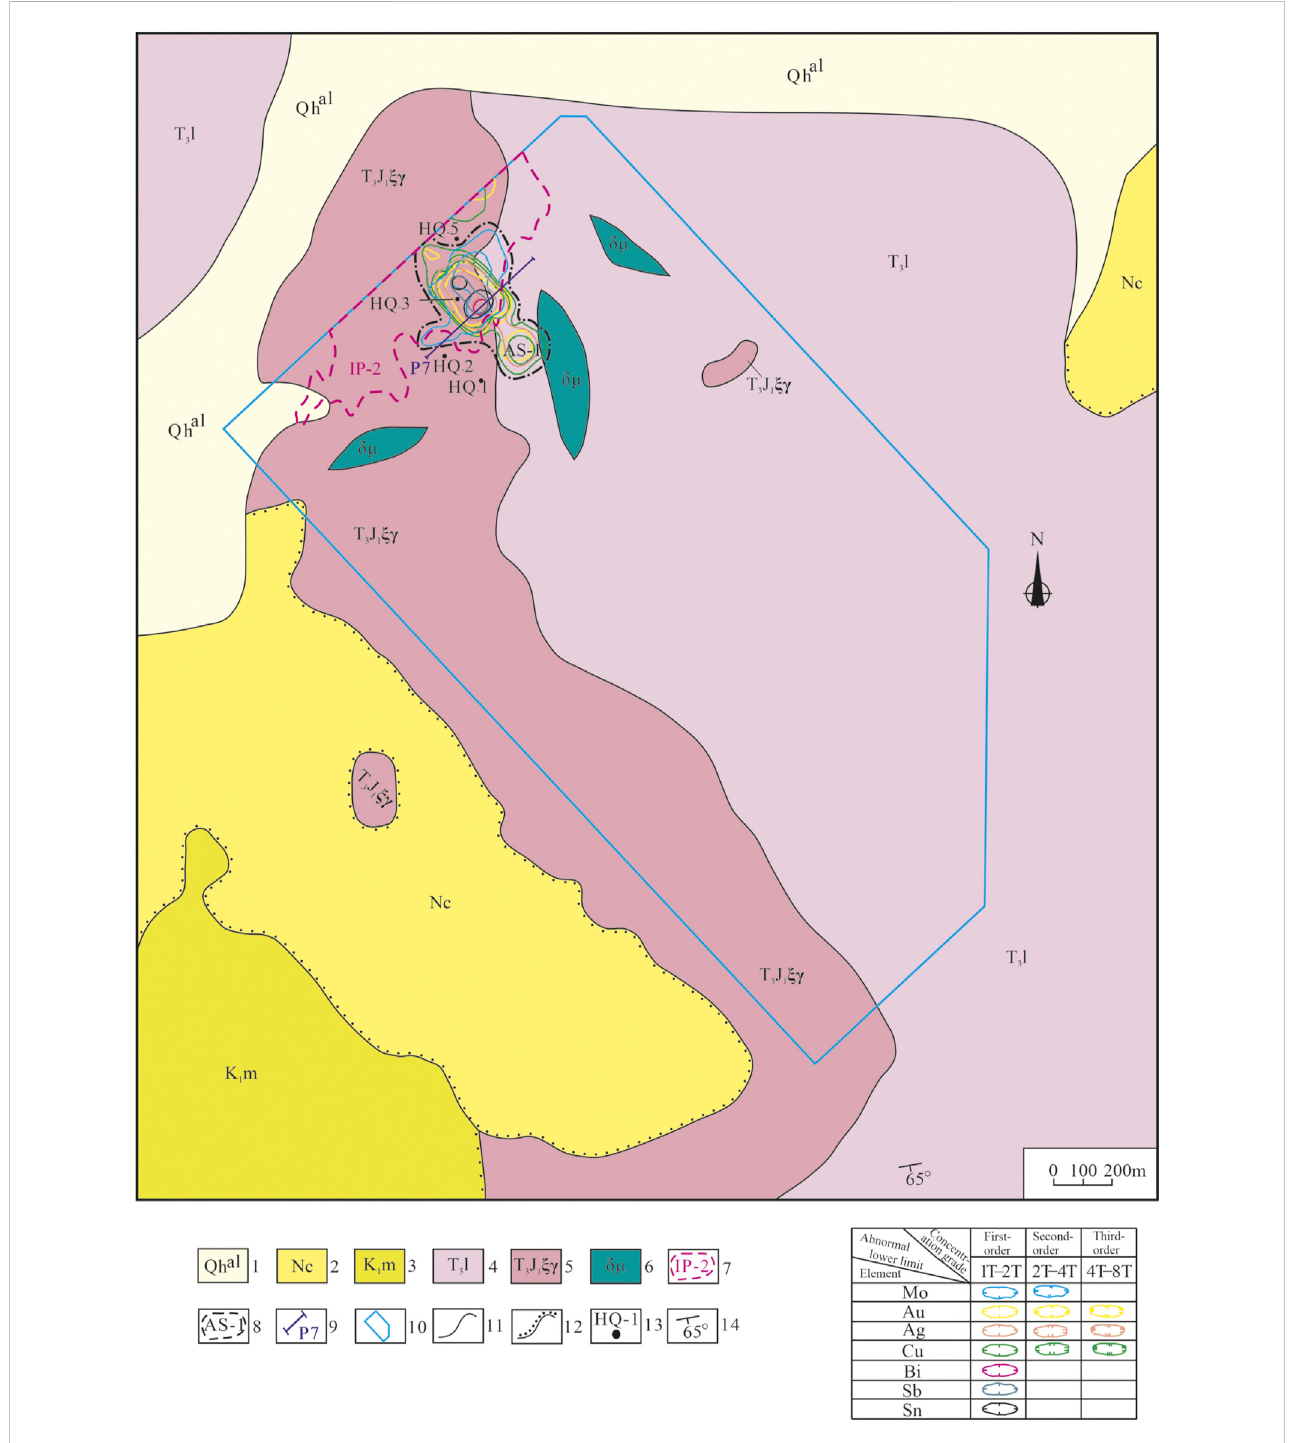
FIGURE 3 Simpli fi ed geological map of the Xinchenggou area, Dongning County. 1-Holocene Epoch Quaternary System; 2-Miocene-Pliocene Chuandishan Formation;3-EarlyCretaceousMulengFormation;4-LateTriassicLuoquanzhanFormation;5-LateTriassic-EarlyJurassicsyenogranite;6-Dioriticporphyrite; 7-Anomaly ofIPMidgradient anditsnumber;8-Anomalyofsoilgeochemicalsurveyanditsnumber;9-Pro fi leofsoilgeochemical surveyanditsnumber;10- Mine fi eld border; 11-Geological boundary; 12-Angular unconformity boundary; 13-Sampling position;